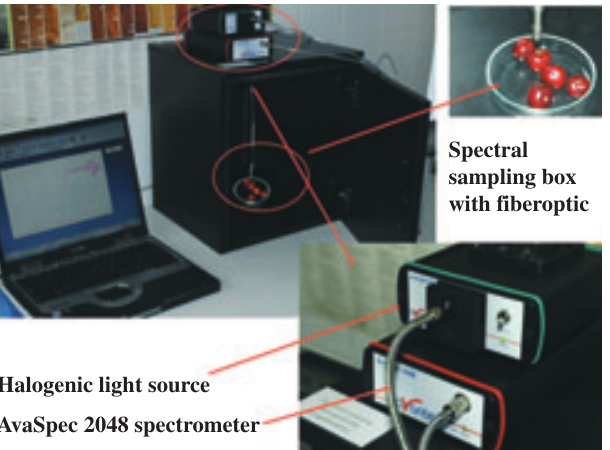
Spectral sampling box